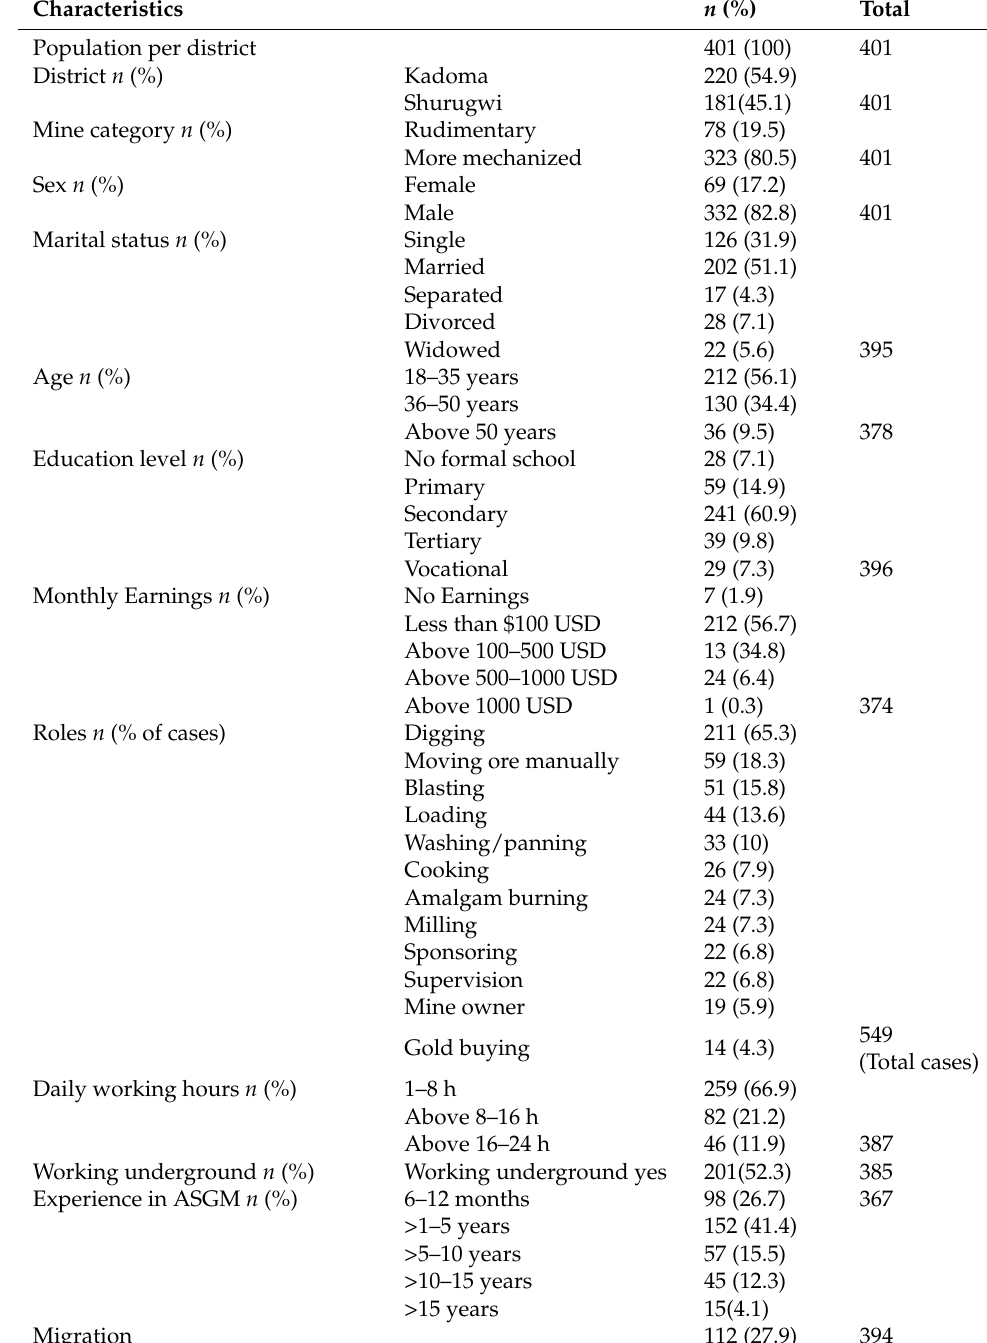
Table 1. Socio-demographics: Socio-demographic characteristics of the miners from Kadoma and Shurugwi in Zimbabwe in 2020 ( n = 401), modified